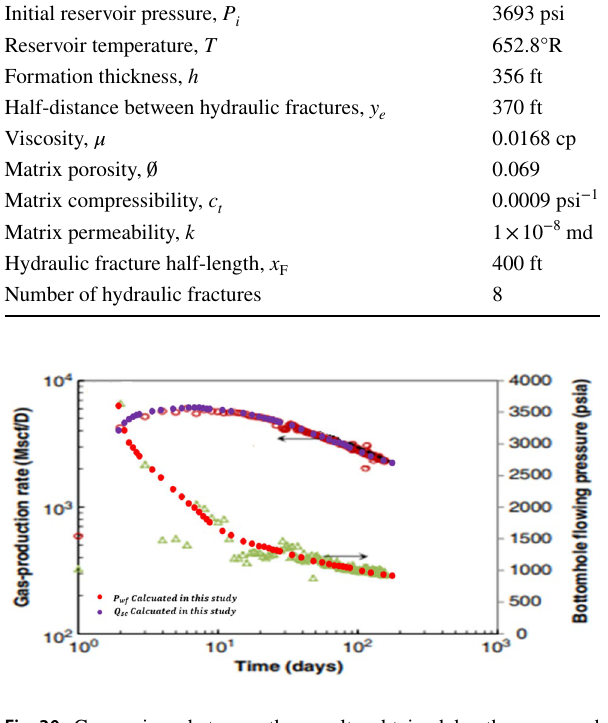
Fig. 30 Comparison between the results obtained by the proposed